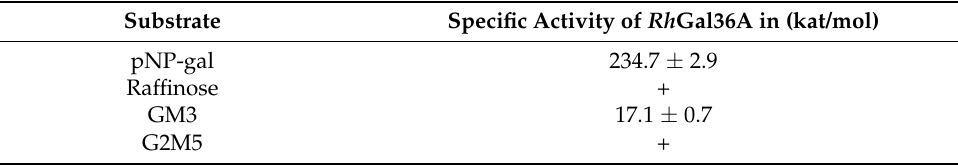
Table 3. Activity of Rh Gal36A on different substrates. Substrate Specific Activity of Rh Gal36A in (kat/mol)